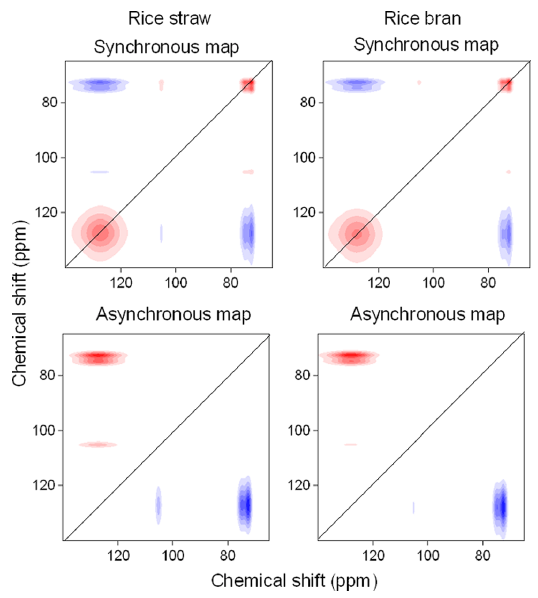
Figure 3. Synchronous and asynchronous 2D 13 C NMR maps of rice straw and rice bran derived biochars over charring temperatures (100 , 600 6 C). Red represents positive correlation, and blue represents negative correlation; a higher color intensity indicates a stronger positive or negative correlation.